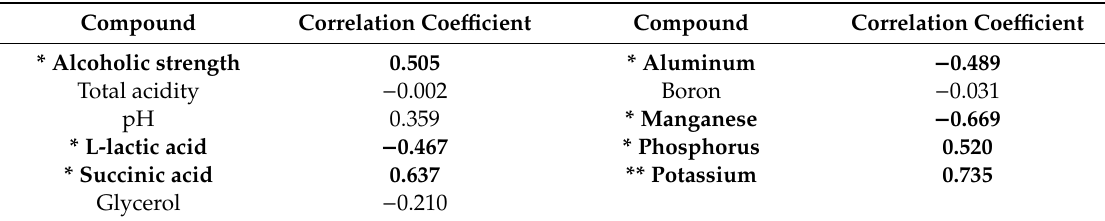
Table 6. Chemical compounds with correlation at a significant level of 60% with the gustatory “minerality” attribute in red wines constructed from the data extracted from the six red wines in